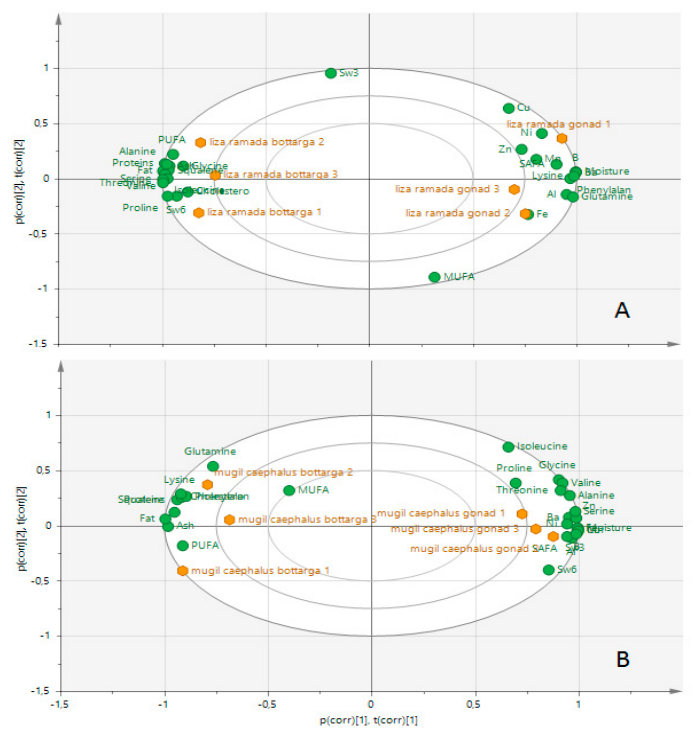
Figure 2. Biplot from PCA analysis of the samples of bottarga vs. fresh roe from Liza ramada ( A ), and Mugil cephalus ( B ).